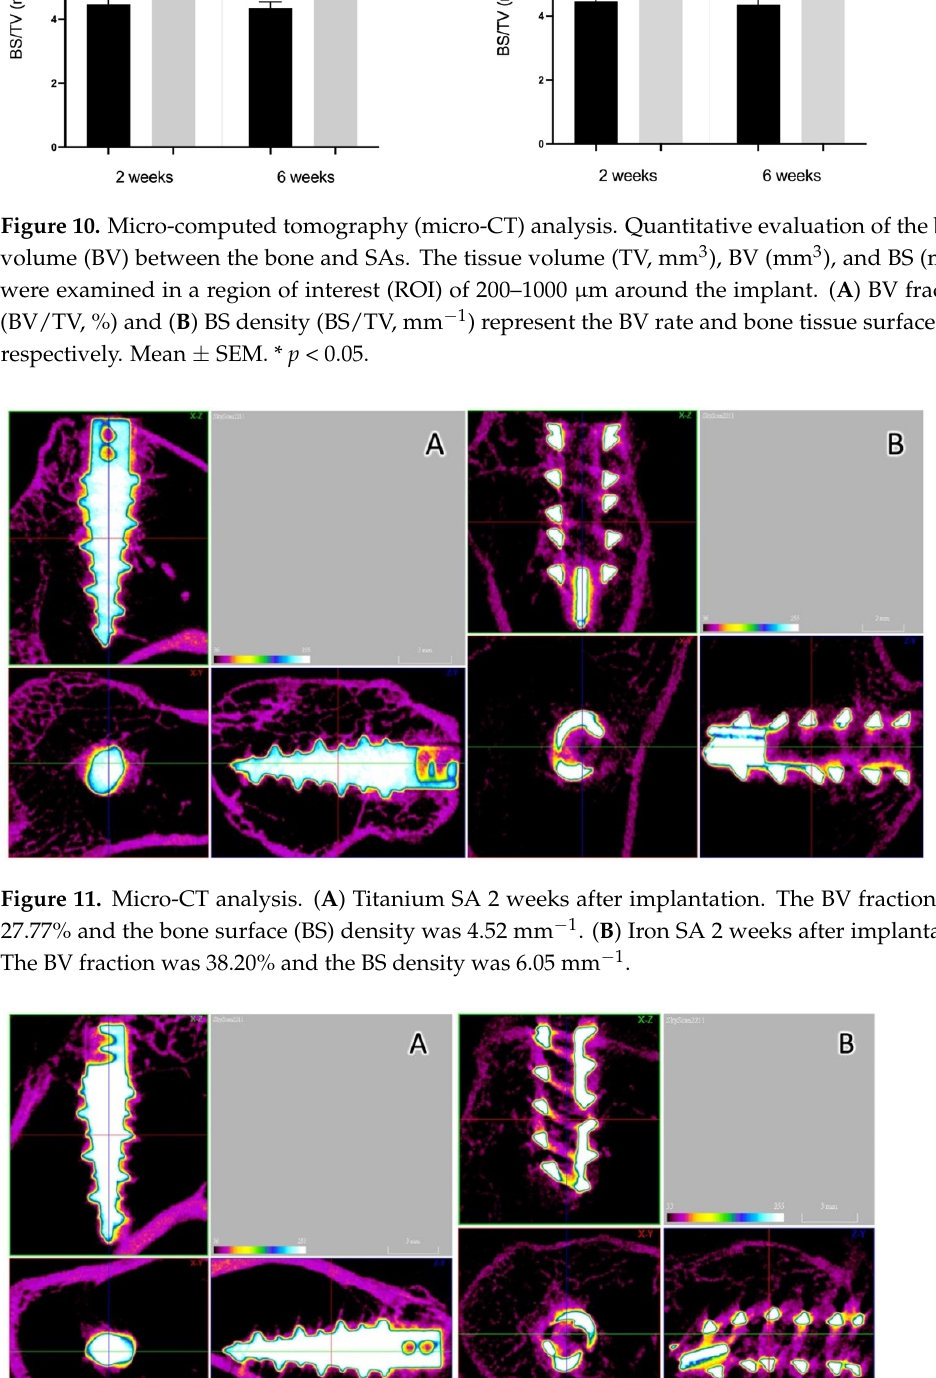
Figure 12. Micro-CT analysis. ( A ) Ti SA 6 weeks after implantation. The BV fraction was 29.59% and the BS density was 4.57 mm −1 . ( B ) Fe SA 6 weeks after implantation. The BV fraction was 39.78% and the BS density was 6.31 mm −1 .